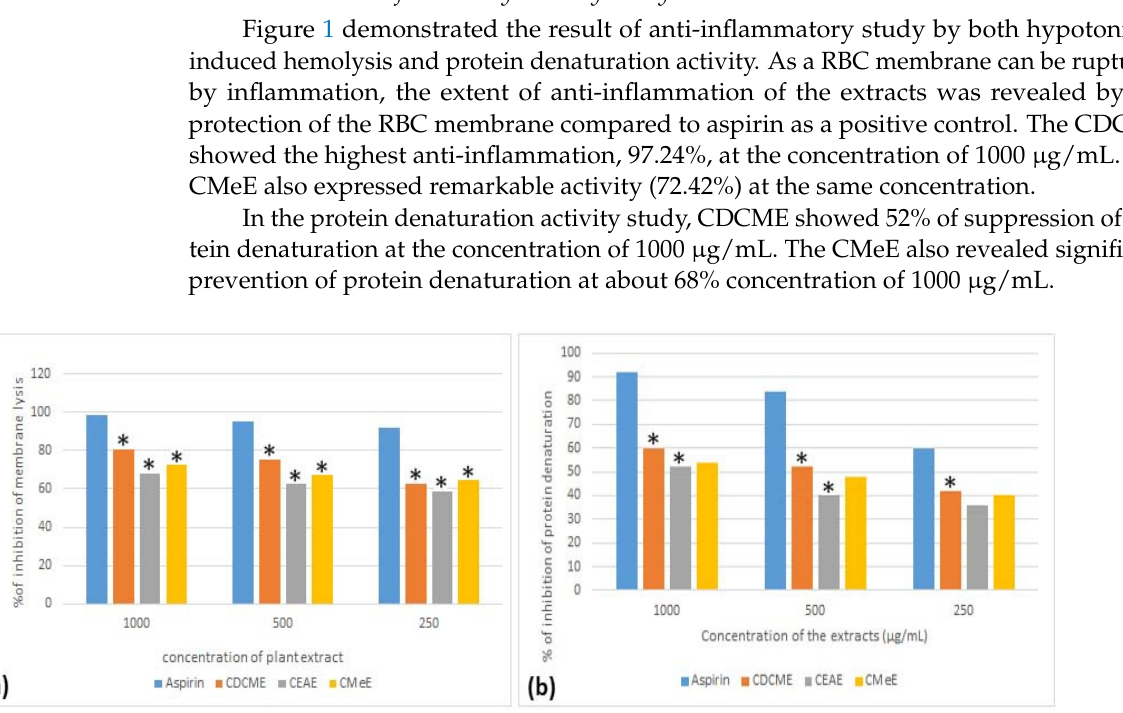
Figure 1. In vitro anti-inflammatory activity study of different extracts of Oldenalndia corymbosa . L at the concentration of 250, 500 and 1000 µ g/mL. ( a ) Percentage of hypotonicity induced membrane stabilization. ( b ) Percentage of protein denaturation. Data are presented as mean ± SD ( n = 5), * p < 0.05 significant level is analyzed by One way ANOVA followed by Dunnett T3 post hoc test for values between the sample and control groups.